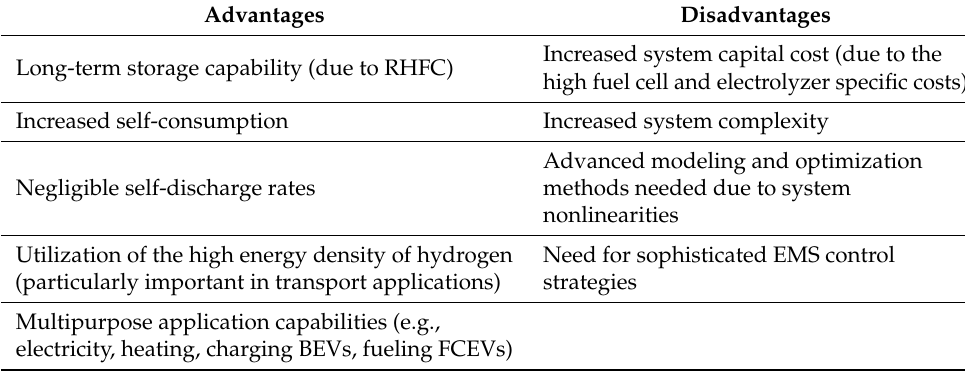
Table 6. Main advantages and disadvantages of hybrid PV-RHFC microgrid